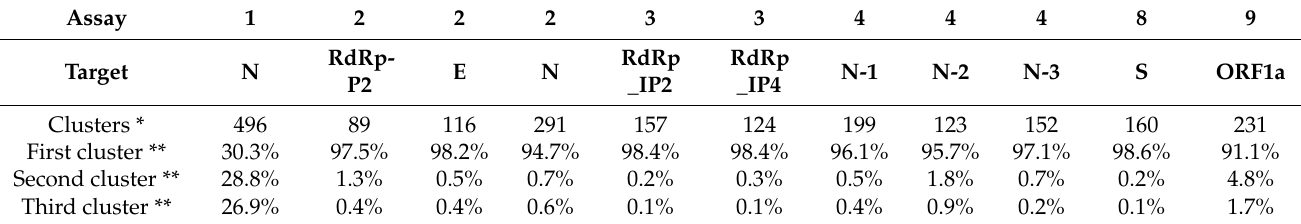
Table 3. Diversity among the sequences amplified by the evaluated primers and probe